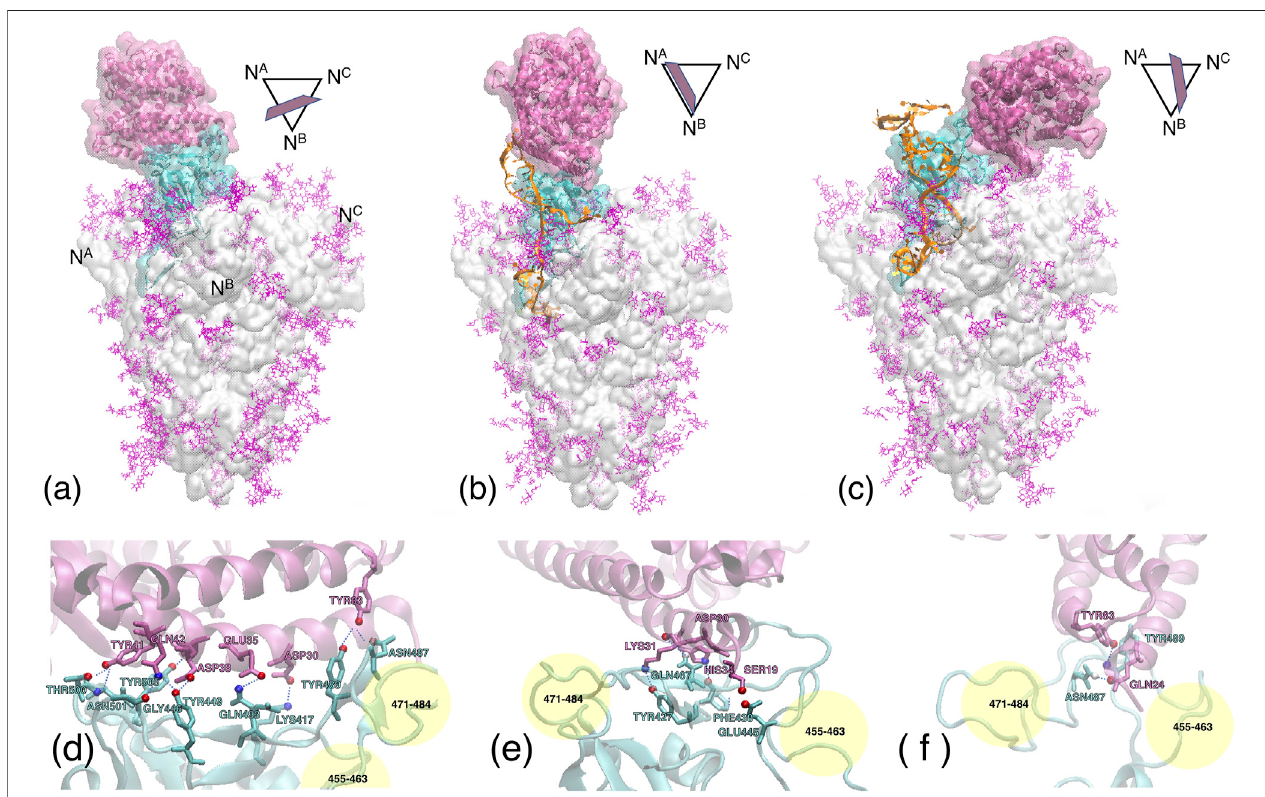
FIGURE 8 | Upper panel Contact regions between the ACE2 receptor (mauve ribbons and transparent surface), the S1 subdomain (cyan ribbons and surface), and the DNA aptamer (orange ribbons). The remaining of the whole S-protein trimer is shown as a light grey transparent surface, with the glycans in purple. (A) Experimentalcon fi guration6M0Jafter50 nsMDequilibration. (B) MDsimulationwiththeapta1. (C) MDsimulationwiththeapta2.ThecentralaxisoftheS-proteintrimer is oriented vertically. The symbols above/right of each fi gure depict the approximate orientation of the α 1 -helix of ACE2, with respect to the cross section of the S-protein [the vertices indicate the N-terminals of each protomer, also reported in the panel (a)]. Lower panel Hydrogen bonds formed at the ACE2/RBD interface, for the experimental con fi guration (D) (only the central region indicated, see Table 1 ); apta1 (D) ; and apta2 (F) . The yellow spheres approximately indicate the regions of residues 455 – 463 and 471 – 484 of the RBD, to provide a relative orientation of the lower fi gures with respect to the panel above.